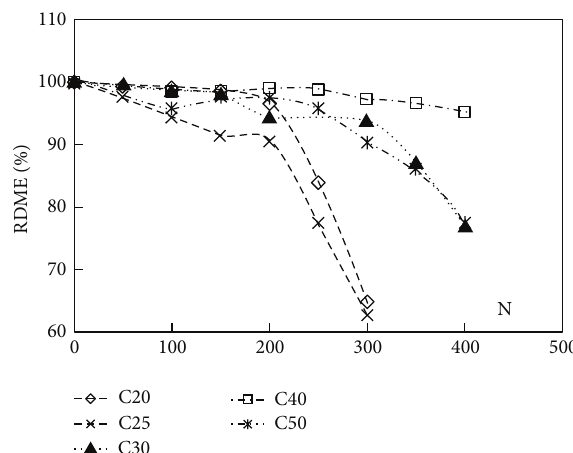
Figure 2: RDME of air-entrained concrete after different cycles of freeze-thaw